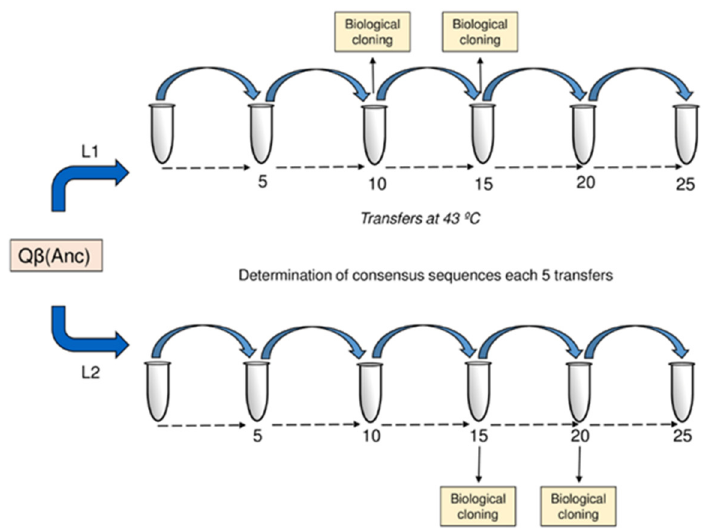
Figure 1. Scheme of the evolution experiment. The figure shows the transfer series experienced by the virus Q β (Anc) to give rise to the evolutionary lineages L1 and L2, as well as the determinations carried out at different points. The virus was transferred for 25 serial transfers (see the section “Evolution Experiment” in Materials and Methods (Section 4)). Consensus sequences were determined each 5 transfers. At the points shown in the figure, the virus populations were plated to isolate biological clones, and whose sequences were also